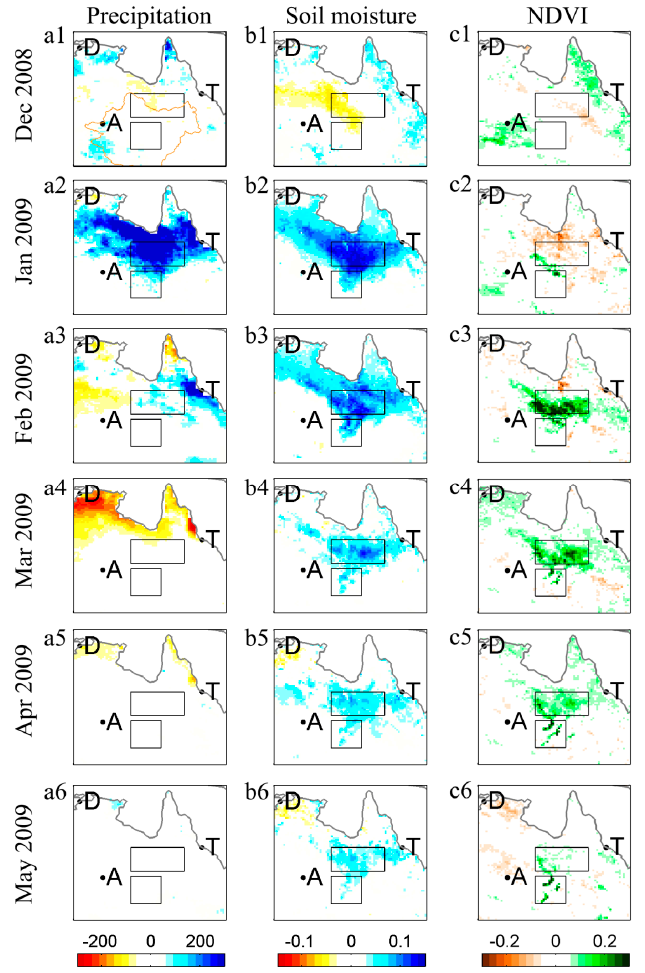
Figure 2. ( a1 – a6 ) Monthly anomalies of gridded precipitation ( left column of panels, mm·month − 1 ), ( b1 – b6 ) satellite soil moisture ( middle column of panels, m 3 ·m − 3 ) and ( c1 – c6 ) NDVI ( right column of panels, unitless) from December 2008 to May 2009. All are at 0.25° spatial resolution. The Lake Eyre Basin boundary is illustrated in subplot a1 (orange line).